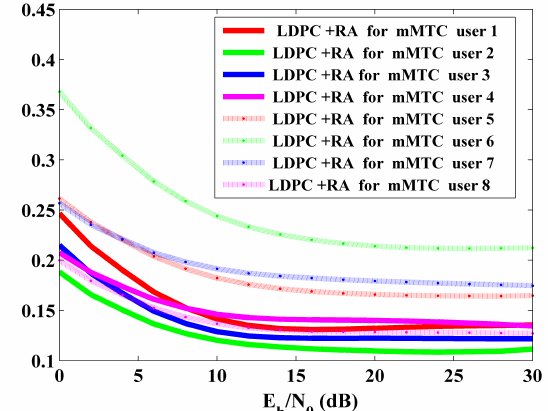
Figure 13. BER analysis of the proposed system adopting LDPC and RA concatenated channel- coding technique.